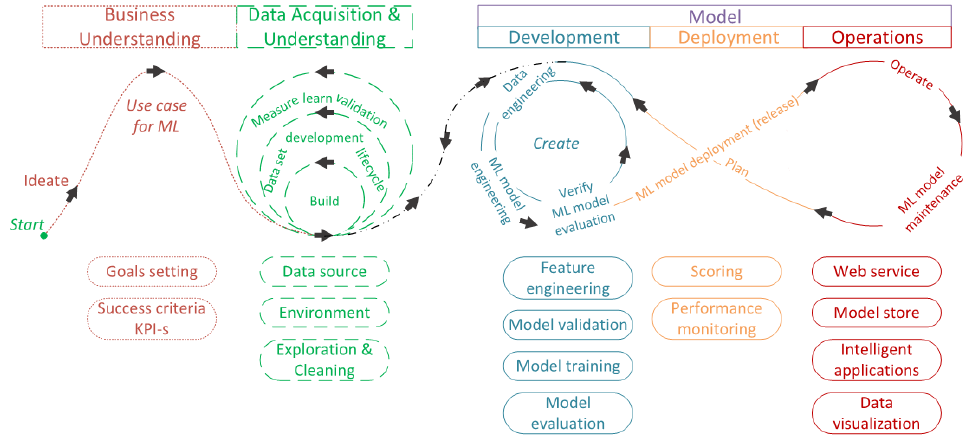
Figure 4. Data science lifecycle management and CRISP-ML. The first part is understanding the business problem (brown) in which goals and success criteria need to be defined. The second stage is understanding the data (green), which involves exploring, cleaning up the data sources and building an environment. The next part is modeling, which has three sub-parts: development of the model (blue), in which it is essential to compete and select different models; deployment of the models (orange), including monitoring the installed models; and operation (purple), which includes data visualization and the development of intelligent applications. The arrows in the figure also illustrate the cyclically of the